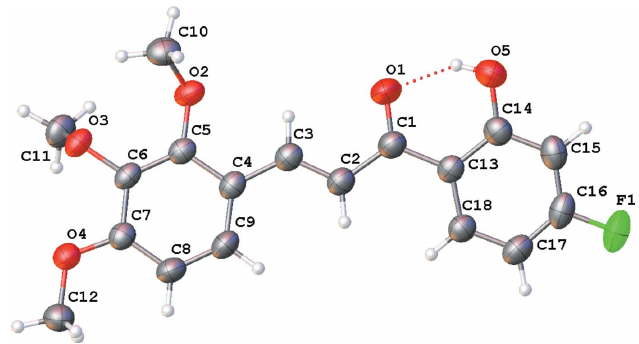
Figure 1 The molecular structure of the title compound, showing the atom- labelling scheme with displacement ellipsoids drawn at the 30% probability level. The intramolecular hydrogen bond is shown as a dashed